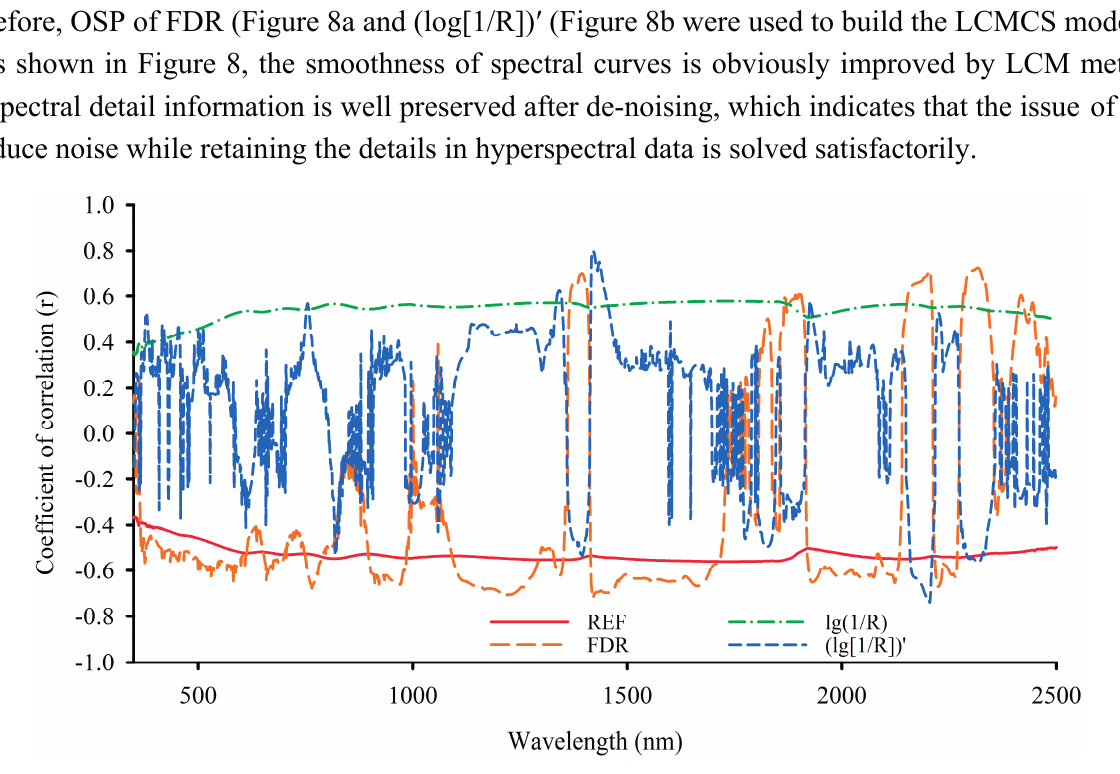
Figure 7. Optimal correlative curve of the original reflectance and its different transformation